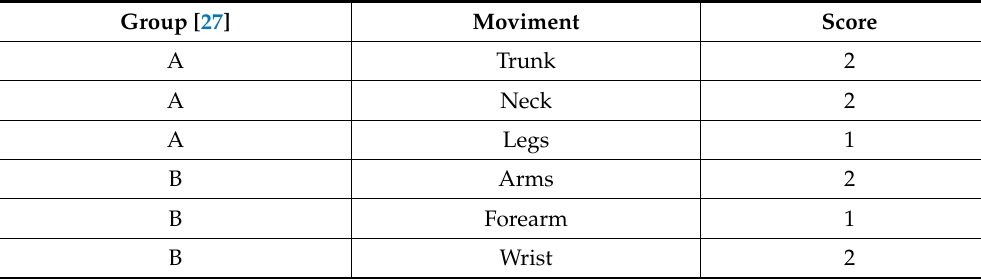
Table 10. REBA group scoring after automation.